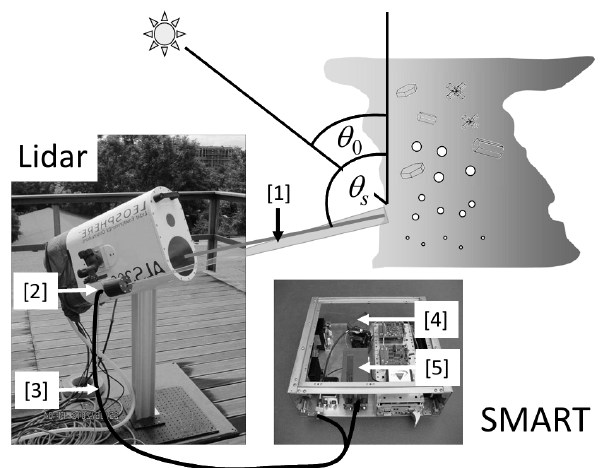
Fig. 1. LIRAS setup consisting of depolarization lidar and SMART- spectroradiometer. (1) Schematic field of view (FOV) of both instru- ments, (2) radiance optical inlet, (3) optical fiber, (4) NIR spectrom- eter, and (5) VIS spectrometer. Additionally, the sensor and solar zenith angle ( θ s , θ 0 ) are